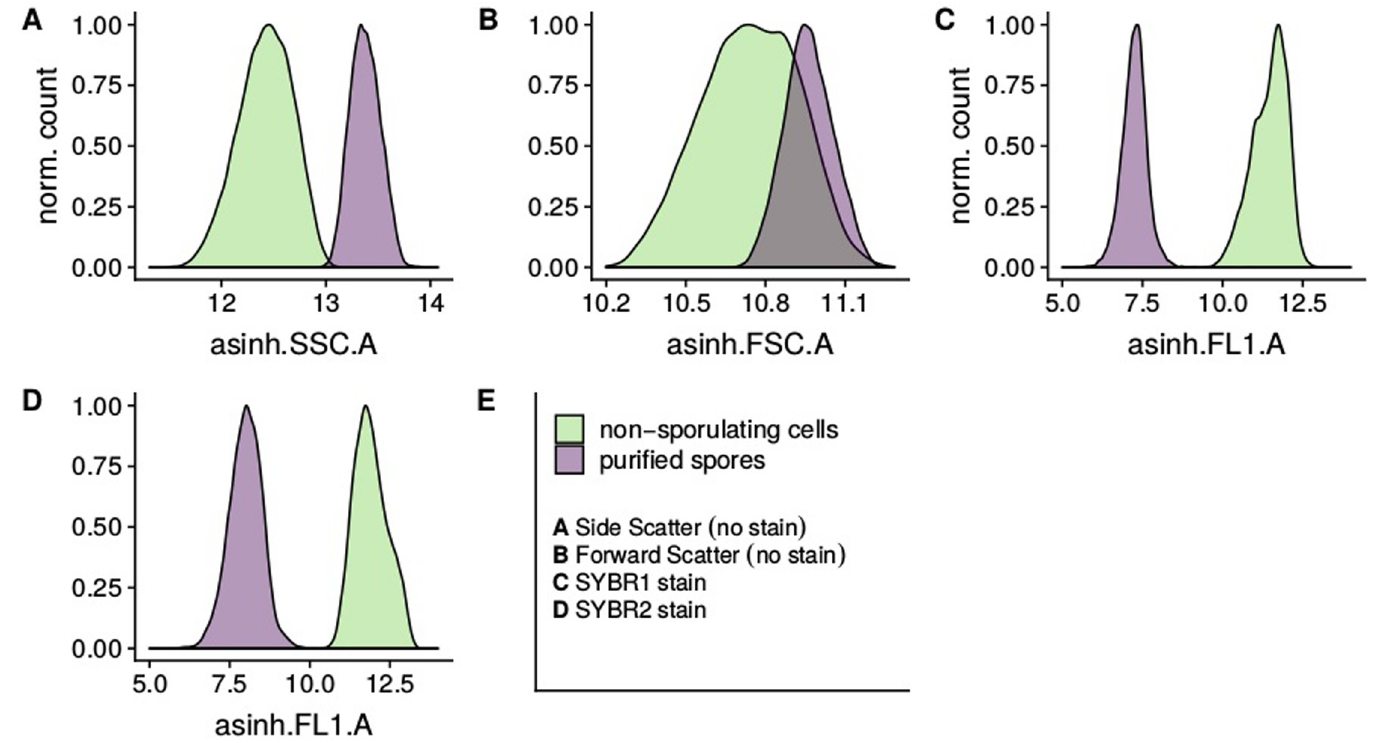
Fig 1. FI and scatter signals of B . subtilis vegetative cells and purified spores measured separately. To measure cells, the non-sporulating Bs02005 strain was employed. Spores were isolated from a culture of Bs02003 according to Nicholson and Setlow, 1990 [35] resulting in a yield of approx 90%.